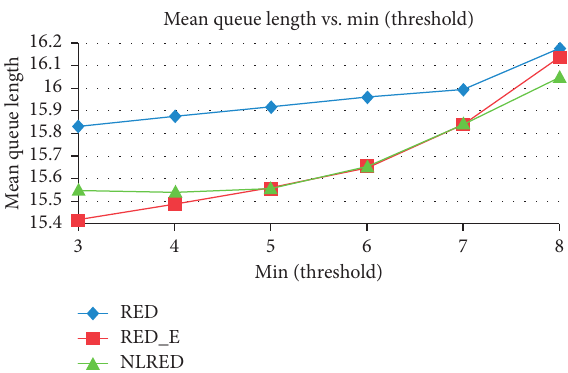
Figure 10: mql versus min threshold.